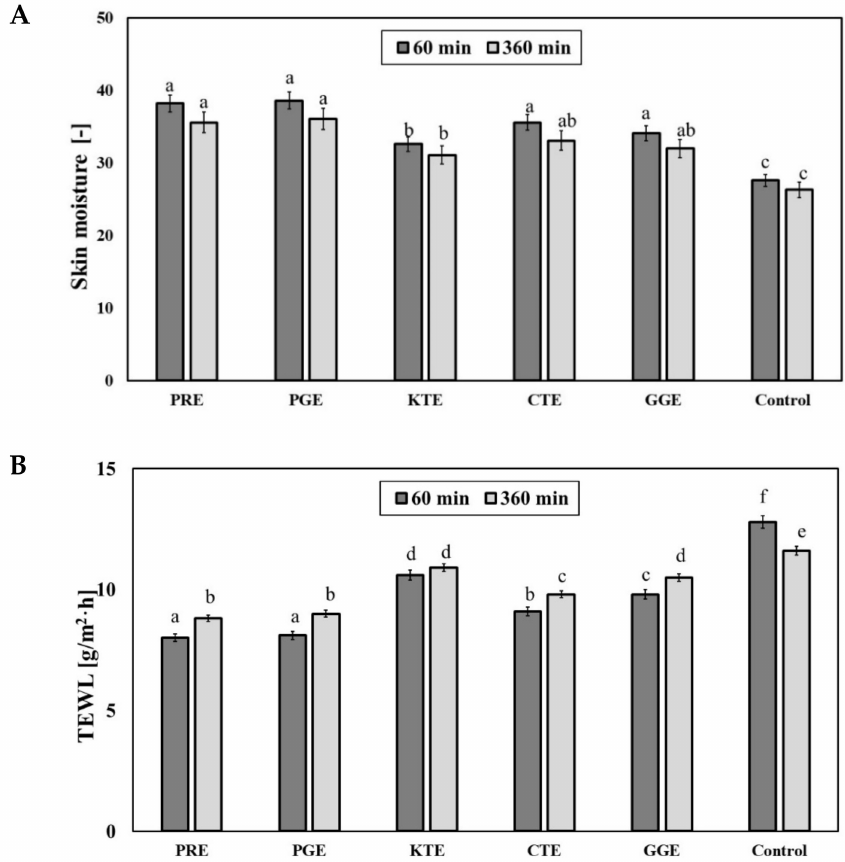
Figure 9. Influence of PRE, PGE, KTE, CTE and GGE extracts on skin hydration ( A ) and TEWL ( B ). Different letters on the charts indicate significant differences between groups ( p <